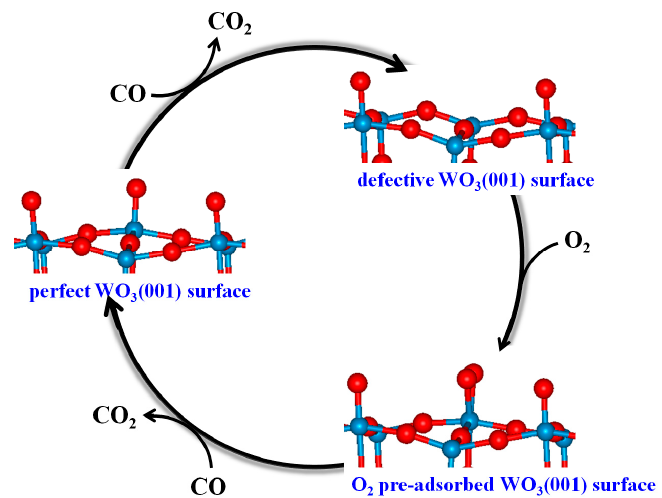
Figure 6. Schematic representation of a possible full sensing cycle of the WO 3 (001) surface as a CO sensor.